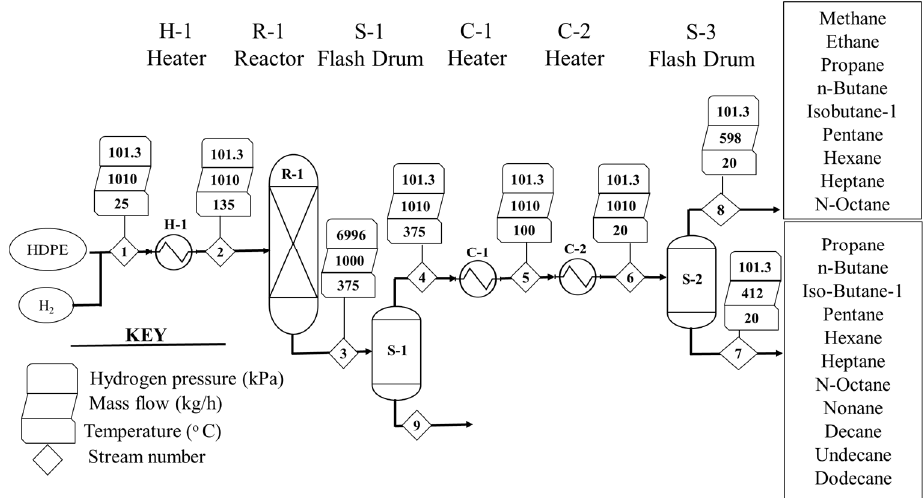
Figure 4. Process flow diagram and stream data for the hydrocracking process. Table 3. Stream data for the hydrocracking process.